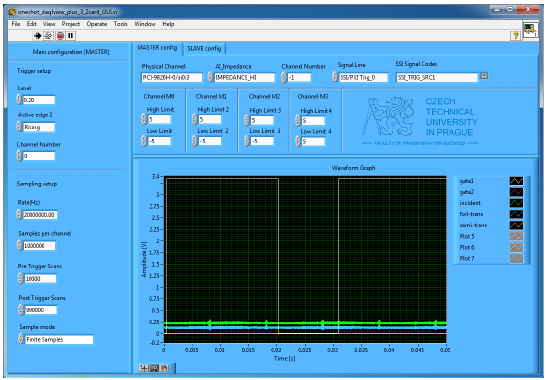
Figure 8. Graphical user interface in LabView.